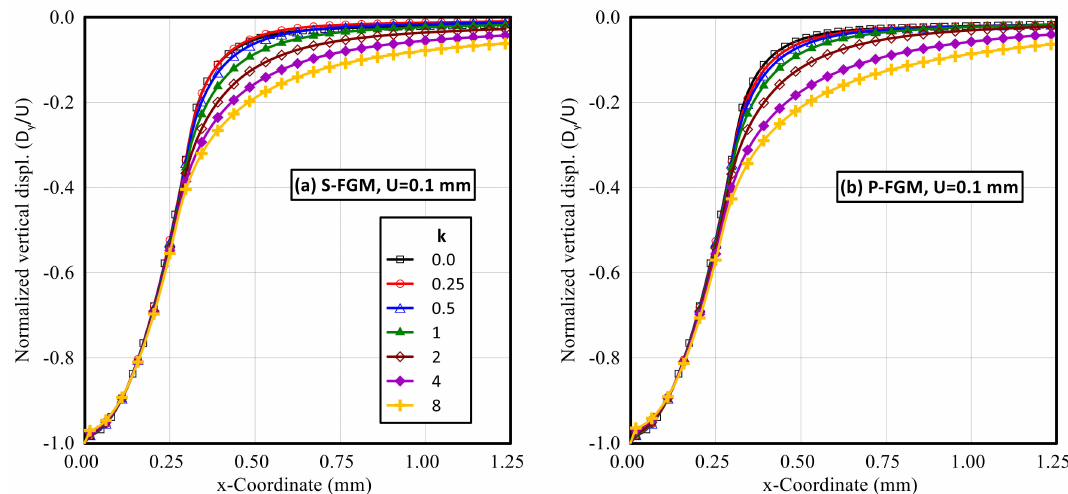
Figure 13. Profiles of the vertical displacement (at full load) along the upper surface of an elastoplastic Ti/TiB specimen at different gradient indices; ( a ) S-FGM, and ( b )